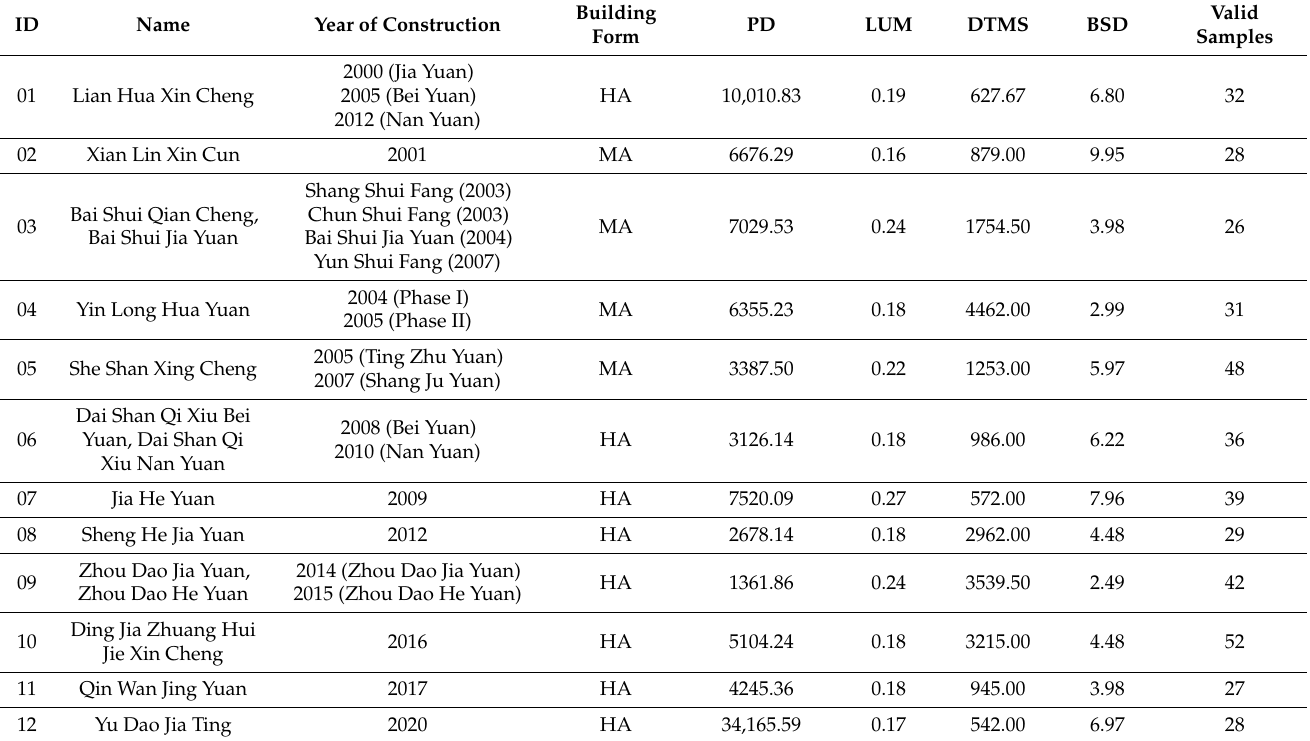
Table 1. Basic characteristics of surveyed